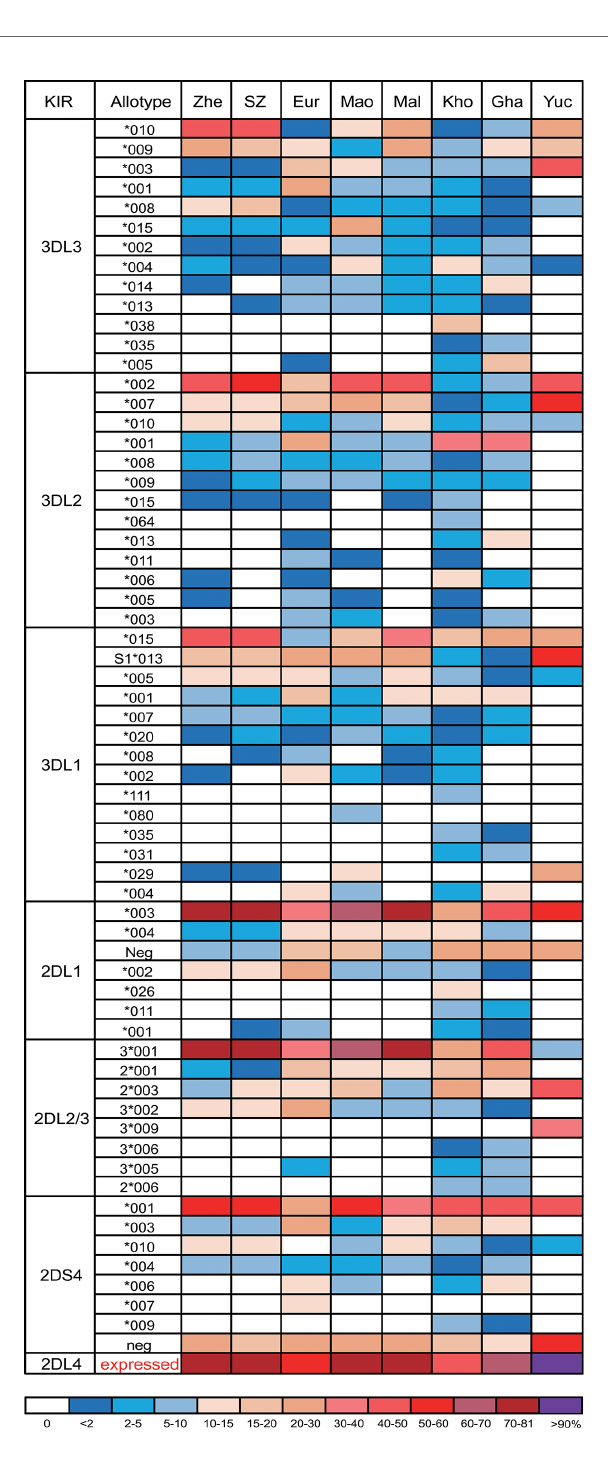
FIGURE 3 | KIR allotype diversity across human populations. Shown are the frequencies of KIR3DL1-3, KIR2DL1-4, and KIR2DS4 allotypes from seven human populations. Shades of dark blue to dark red represent the allotype frequencies from low to high as indicated in the key at the bottom. Zhe, Zhejiang Han; SZ, Shenzhen Han (36); Eur, European (65); Mao, Ma ̄ ori (62); Mal, Malay (45); Kho, Southern Africa Khomani (34); Gha, sub-Saharan Africa Ghanaian (49); Yuc, Amerindian Yucpa (50). For KIR2DL4, the sum of expressible allotypes is shown. * standard WHO nomenclature for KIR